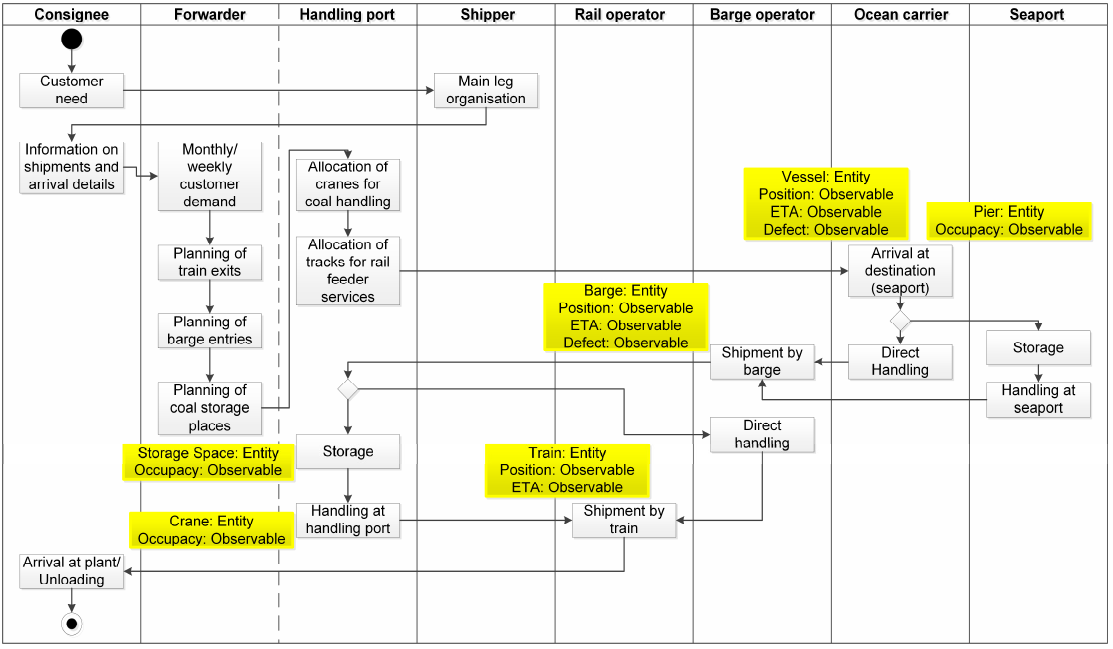
Figure 11. Activity diagram of the transshipment use case example with exception-related events. Logistics 2018 , 2 , x